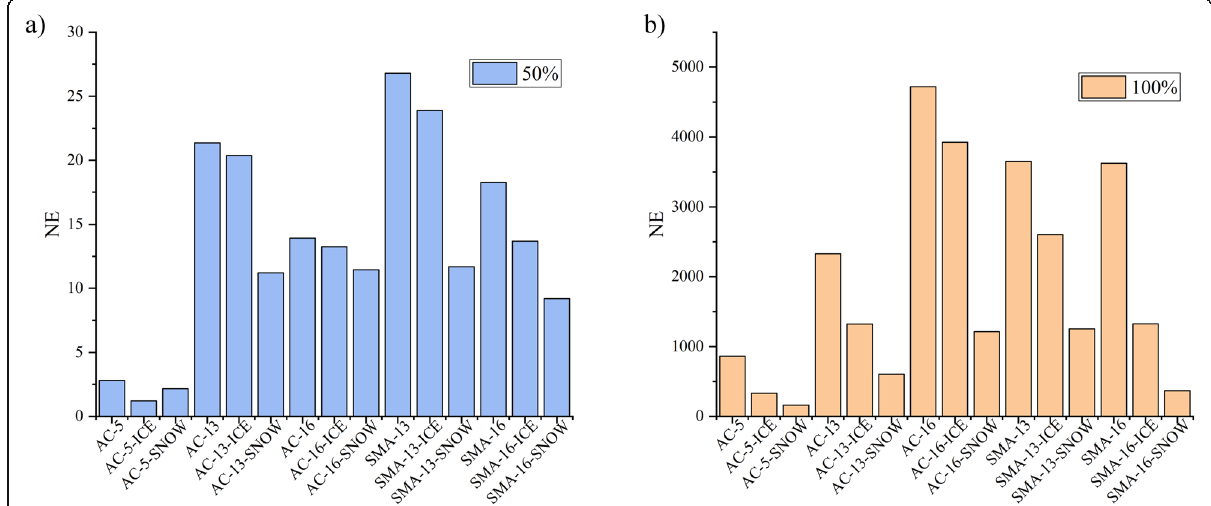
Fig. 12 The NE result; a The NE results on 50% cutting plane, b the NE results on 100% cutting